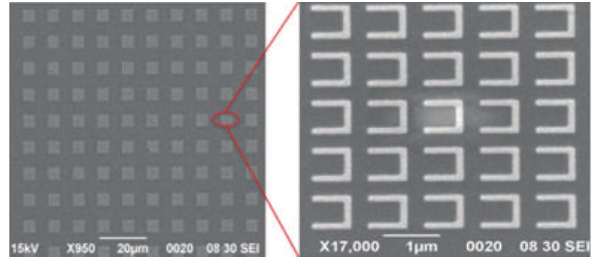
Figure 7: The SEM images of the fabricated planar SRRs. The sam- ple consists of 5 × 5 SRRs as a unit cell through standard e-beam lithographic and lift-off processes